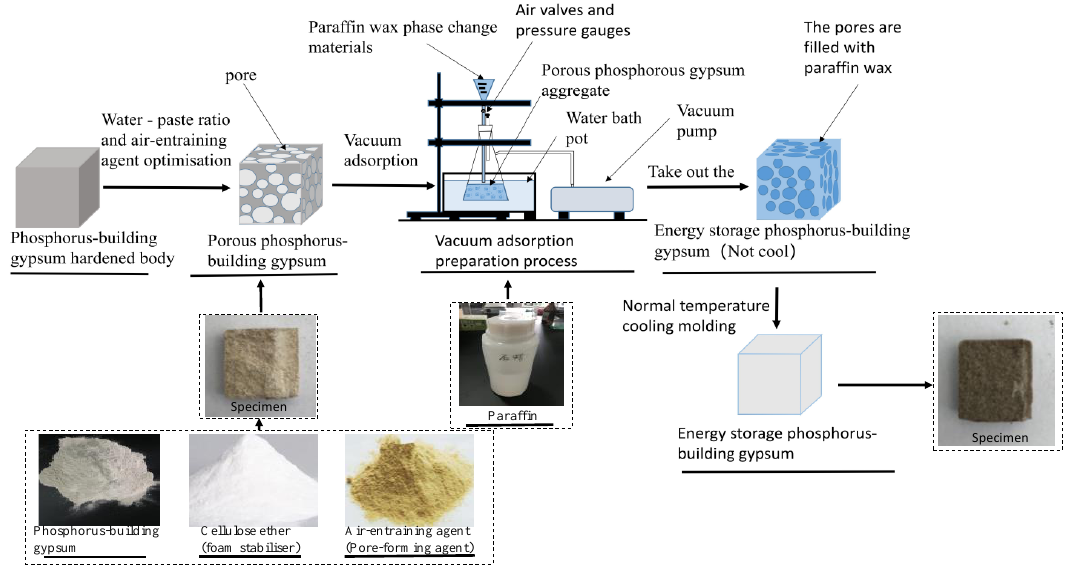
Figure 1. Schematic diagram of the vacuum adsorption process of the phosphorus gypsum test block.